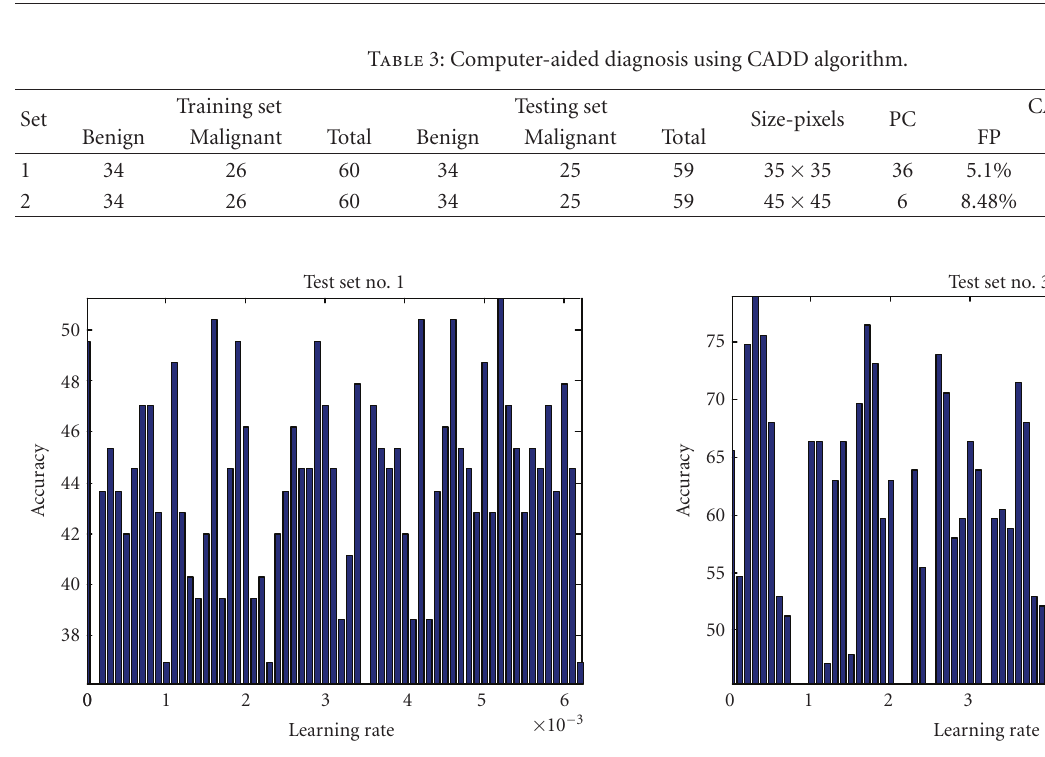
Figure 6: Learning rate impact on algorithm accuracy for test set no. 3 where other parameters are kept constant.